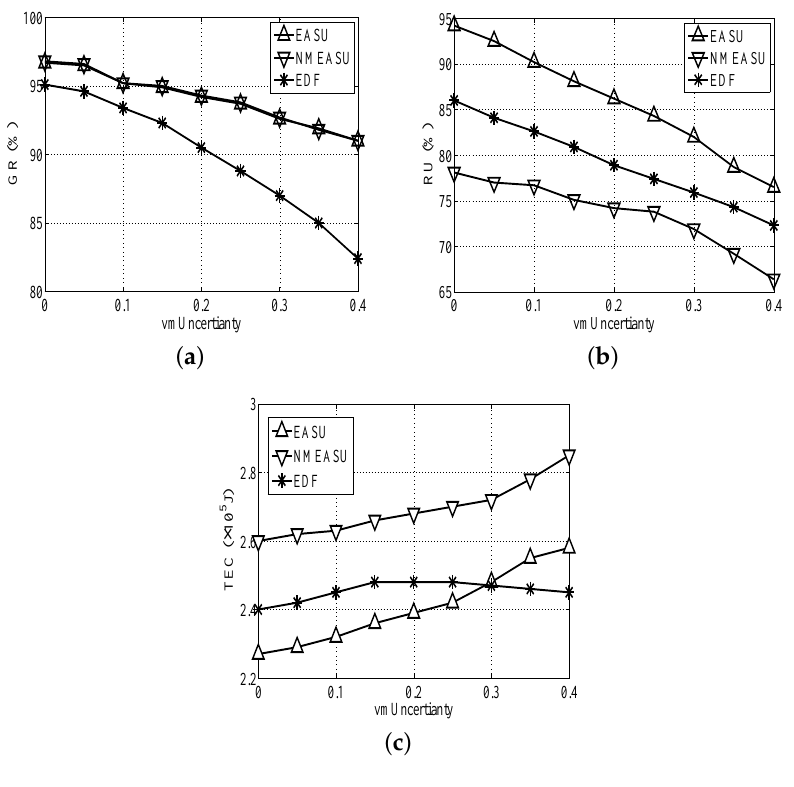
Figure 4. Performance impacts of task deadlines. ( a ) Impact of VMUncertainty on GR, ( b ) Impact of VMUncertainty on RU, ( c ) Impact of VMUncertainty on